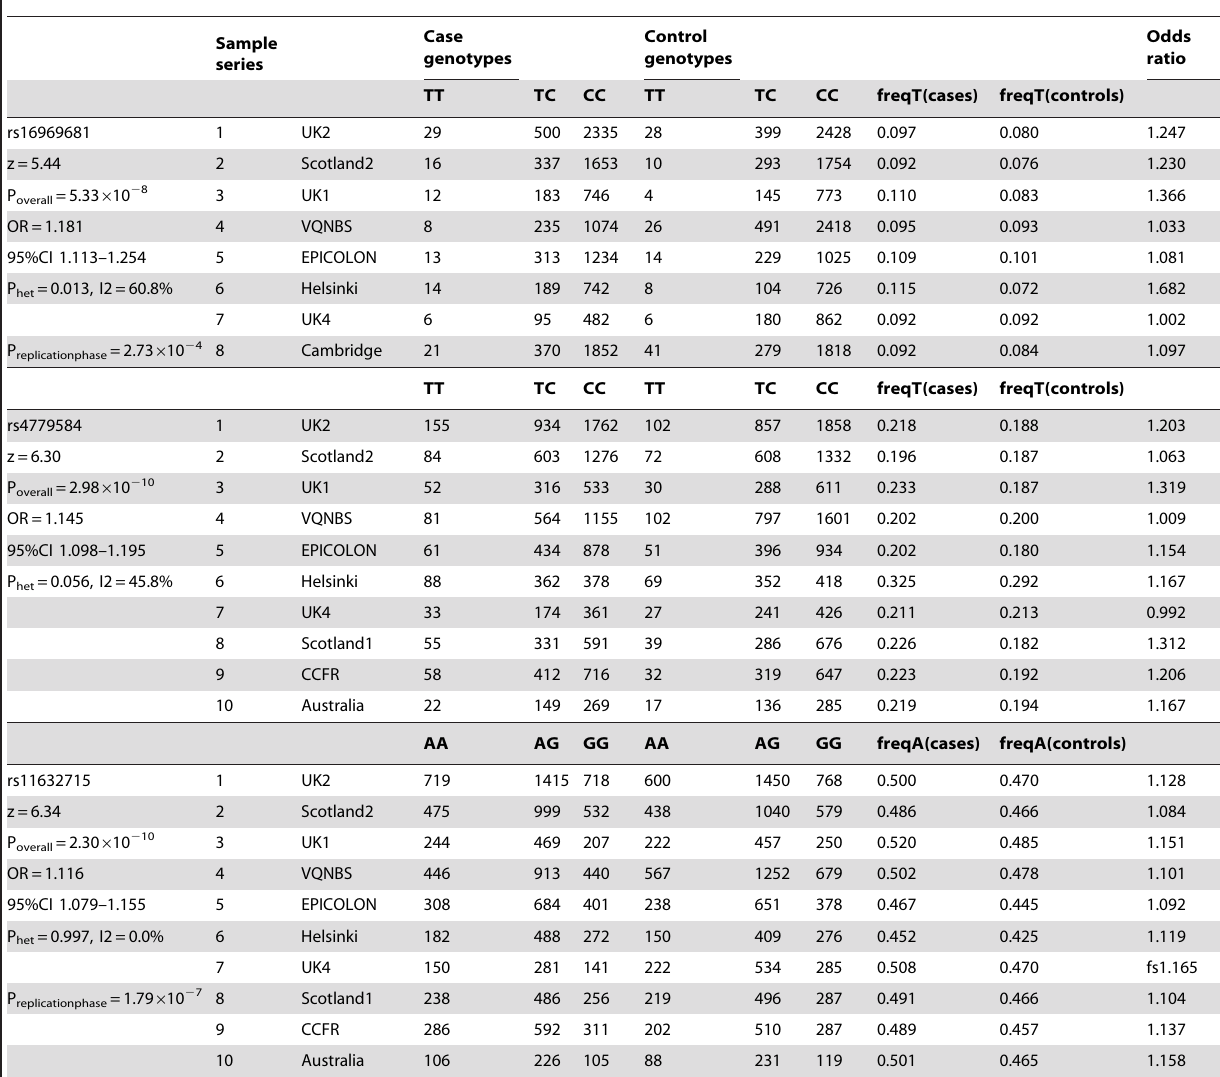
Table 1. Genotype counts and statistics of association at rs16969681, rs11632715, and rs4779584.